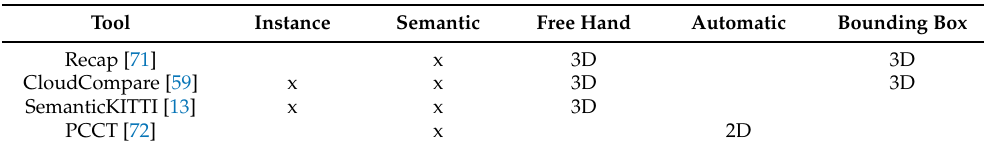
Table 4. Selection of annotation tools (x = present). Distinguished for instance and for semantic segmentation. Segmentation is performed in 2D or 3D with free-hand tools, automatically or with bounding boxes or geometries. Tool Instance Semantic Free